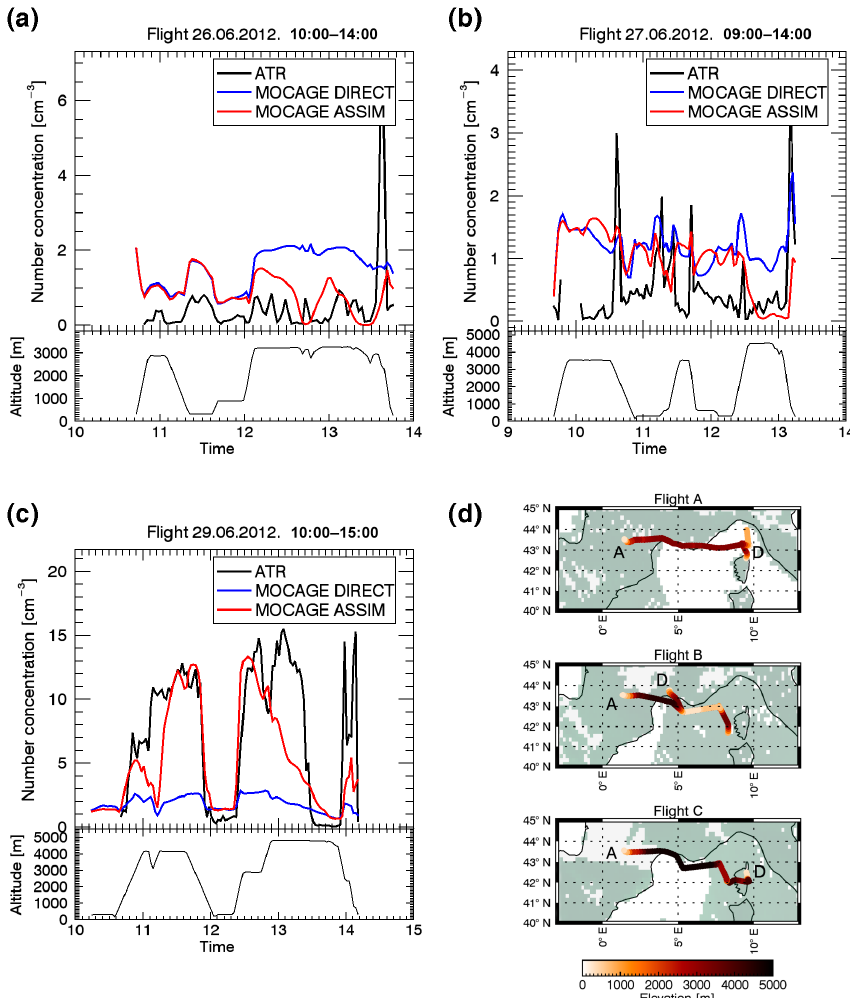
Figure 8. Aerosol number concentration (cm − 3 ) from the PCASP instrument on board the ATR aircraft (black line) compared with the direct model run (blue line) and the assimilation model run (red line) for three different flights: flight A on 26 June 2012 (a) , flight B on 27 June 2012 (b) and flight C on 29 June 2012 (c) . The altitude of the aircraft is also given for all three flights. In addition, the maps of flight tracks are presented (d) with the points of departure (D) and arrival (A) for each flight, and the positions of the assimilated observations during the day of flight (dark green). The colours of the tracks represent the altitude of the aircraft during the flight, with values defined in the colour bar. The aerosols are considered in the size range from 1 to 2 .